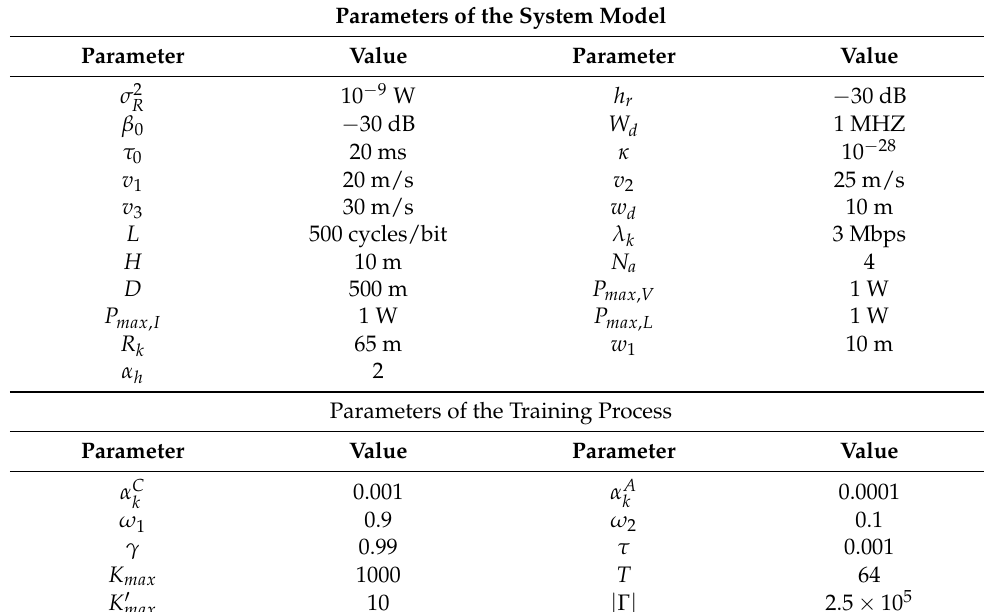
Table 2. Key parameters in simulations.